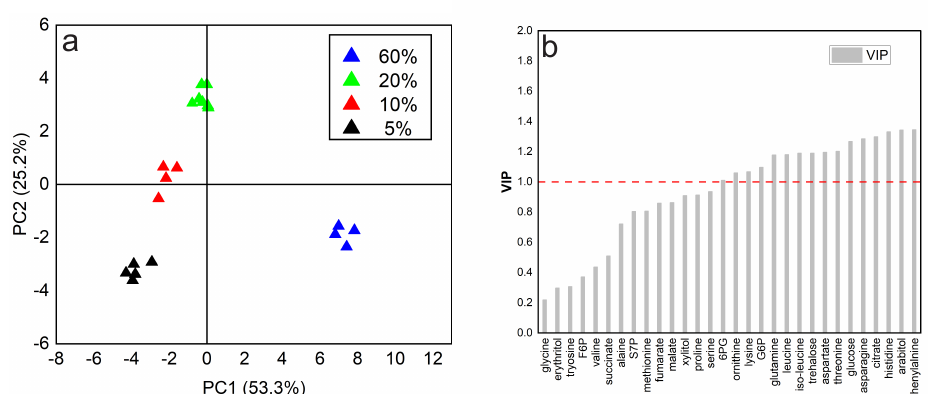
Figure 4. Analysis of metabolomics data under different steady-state dissolved oxygen concentrations. ( a ) Principal component analysis (PCA)-derived score plot of the first two principal components and ( b ) VIP score for 30 intracellular metabolites calculated with the PLS model.